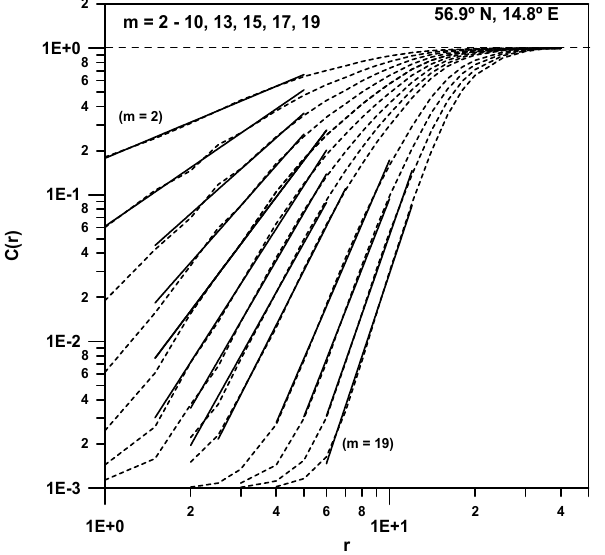
Fig. 7. An example of the correlation function (dashed lines) of a DSL series and linear evolution on a log-log scale (solid line) for m ranging from 2 to 19.